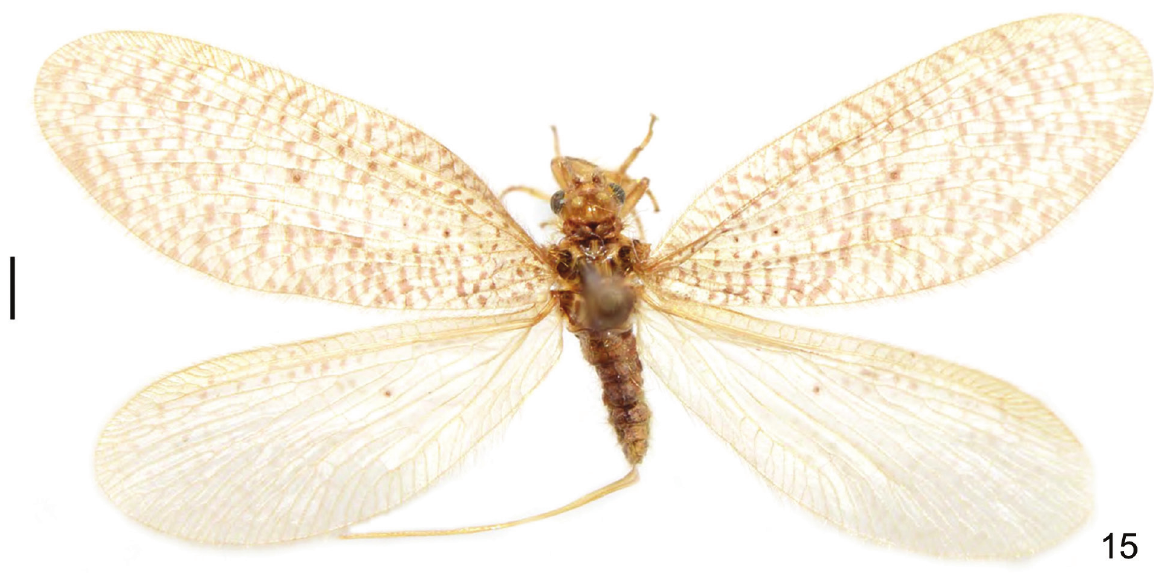
Head pale yellowish brown, with pale yellow setose tubercles. Compound eyes blackish brown. Antenna with ca. 29 segments, pale yellow, with scape and pedicel pale brown, flagellum unipectinate on most flagellomeres, medial branches much longer than those on both ends, longest branch nearly 3.0 times as long as the correspond- ing flagellomere, but branch of 1st flagellomere short and dentate, distal eight flagellomeres